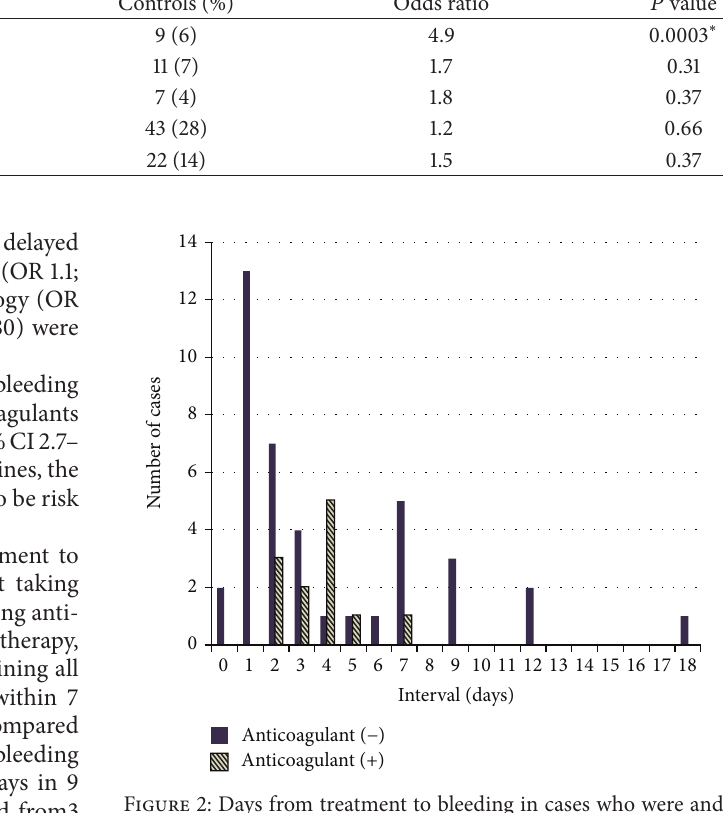
Figure 2: Days from treatment to bleeding in cases who were and were not taking anticoagulants. Delayed bleeding occurred within 7 days in most cases